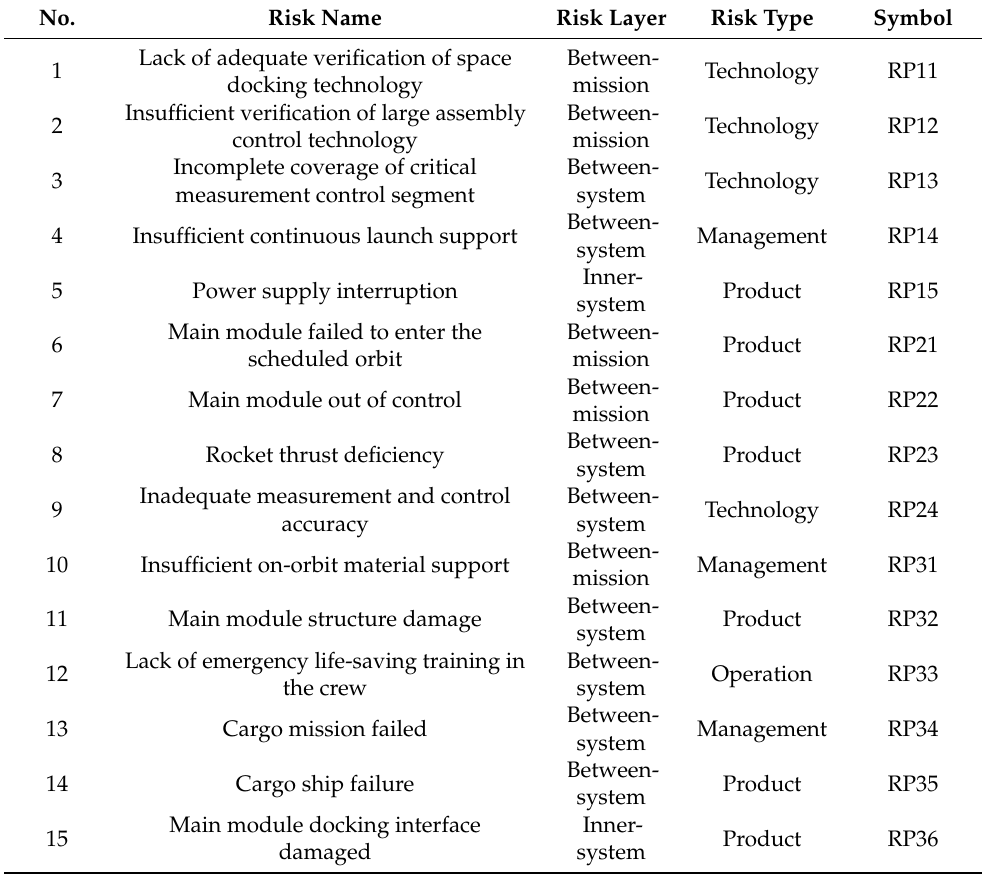
Table 5. High load risks of the space station configuration